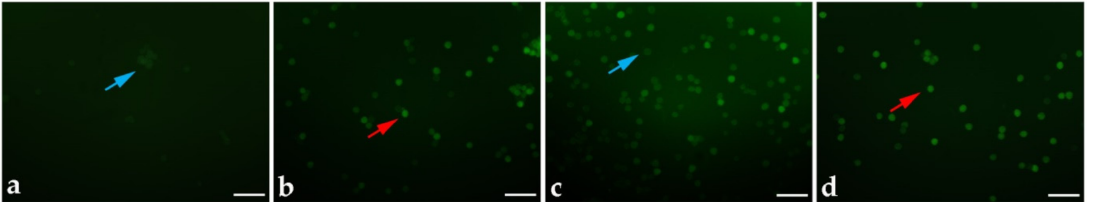
Figure 1. FDA-stained pollen grains after 12 months of storage: ( a ) at 4 ◦ C; ( b ) at − 20 ◦ C; ( c ) − 80 ◦ C; ( d ) − 196 ◦ C. Scale bars = 200 µ m. Blue arrows—non-viable pollen grain; red arrows—viable pollen